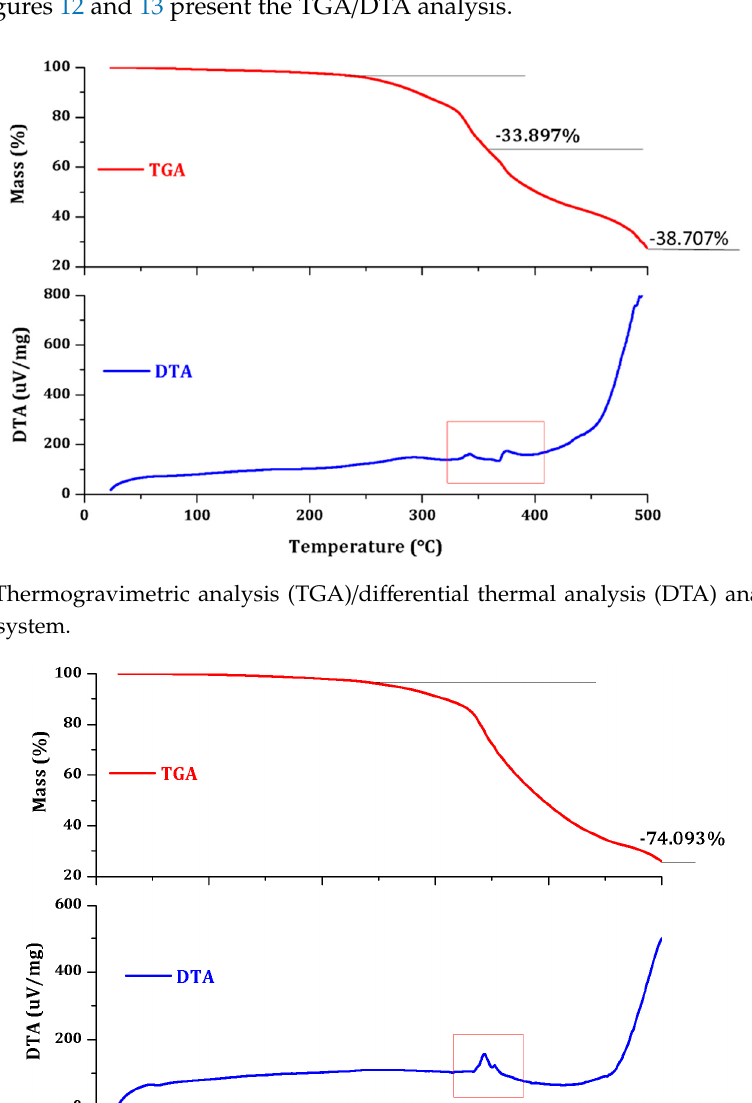
( b ) Figure 14. TEM images presenting the core-shell structure of synthetized ( a ) PUF-DCPD and ( b ) MUF- ENB microcapsules. 2.6. Fabrication of Reference Specimens Prior to the integration of self-healing systems in the epoxy matrix and evaluation of their mechanical properties, an investigation was conducted to find the optimal matrix curing cycle. Different curing cycles were investigated for the epoxy system Resoltech 1050 and Hardener 1055S, in order to achieve the best mechanical properties; firstly, according to the technical data parameters